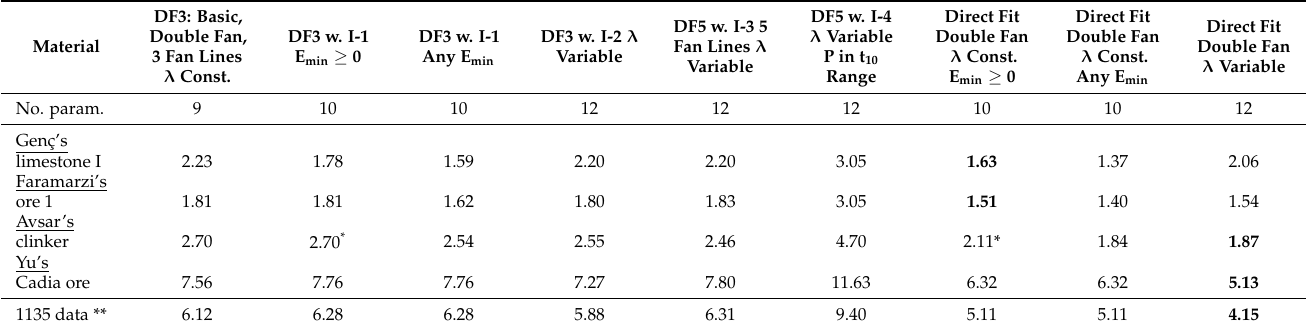
Table 7. Mass passing fidelities of the different versions of the double fan (DF) for selected materials, measured as the errors RMSE. Bold numbers refer to examples plotted in Figures 14 and 15, and Appendices C and D. DF3: Basic, Double Fan, Material